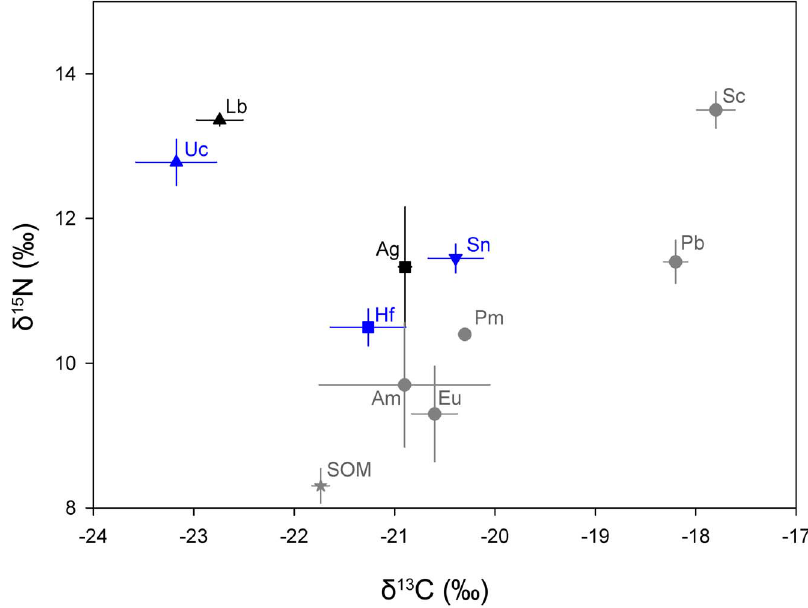
Figure 8. Stable isotope values ( d 15 N and d 13 C) for sea pens (Ag: Anthoptilumgrandiflorum and Hf: Halipterisfinmarchica ) and their associated species (Lb: Lamippebouligandi , Sn: Stephanaugenexilis and Uc: undescribed Corallovexiidae). To locate and compare the signature of the sea pens, values for other invertebrates are shown, Am: Amphipods, Eu: Euphausiids, Pm: Pasiphae multidentata , Pb: Pandalus borealis and Sc: snow crab from Sherwood & Ross [42], as well as sedimentary organic matter (SOM) from Muzuka & Hillaire-Marcel [41]. Result shown as mean 6 SE (n=2–5). Black: A. grandiflorum and its associates, Blue: H. finmarchica and this associates, Grey: other invertebrates and SOM.